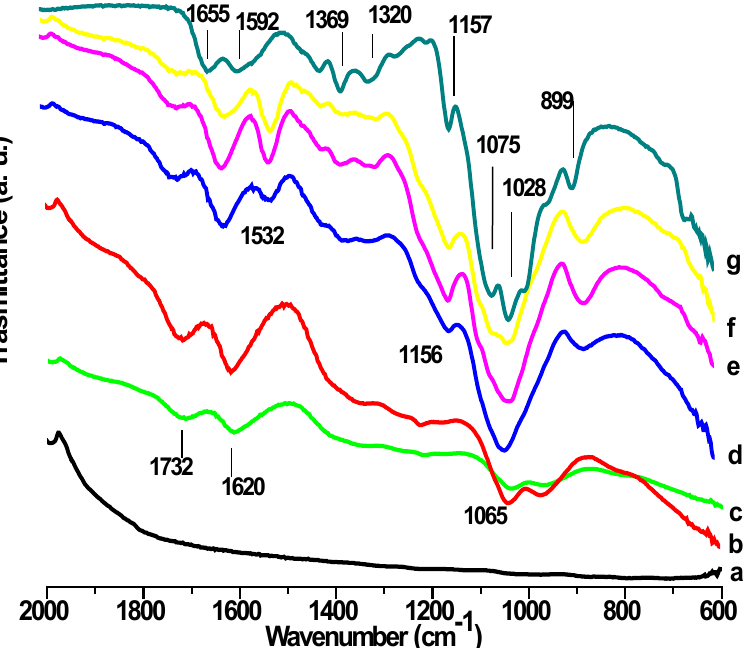
Figure 3. Fourier transform infrared spectroscopy (FTIR) spectra of: ( a ) graphite; ( b ) GO; ( c ) GEO; ( d – f ) chitosan-grafted graphene oxide at different temperatures of treatment: ( d ) CGEO1; ( e ) CGEO2; ( f ) CGEO3 and ( g )